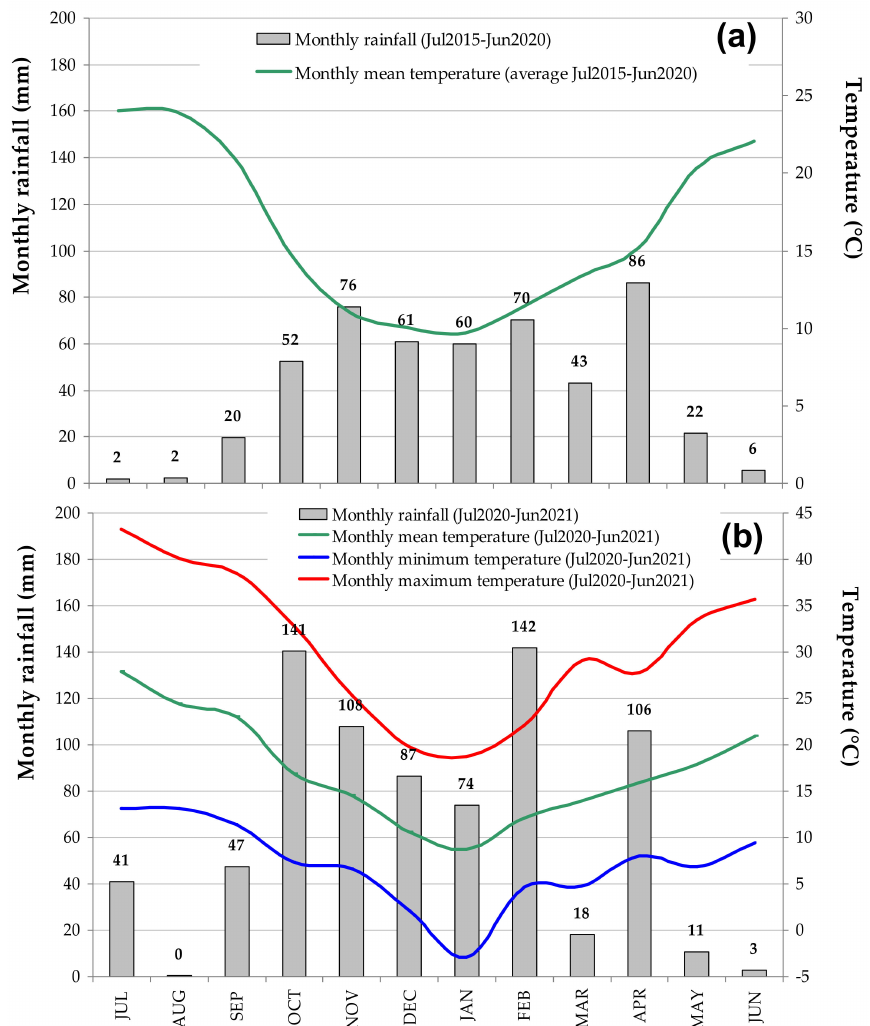
Figure 3. Thermo-pluviometric diagram of the Meteorological Station of Mitra ( É vora, Portugal) between July 2015 and June 2020 ( a ) and between July 2020 and June 2021 ( b